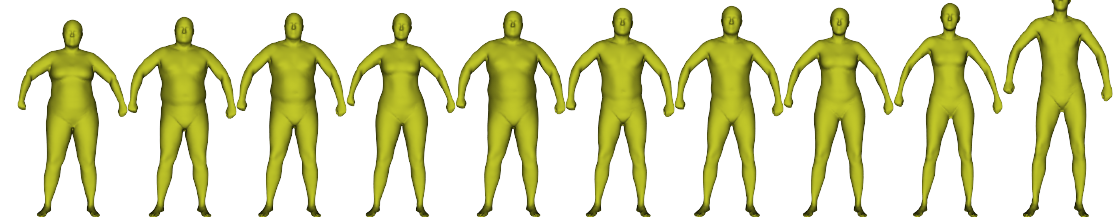
Figure 7. Ten representative human subjects of the same pose in the SHREC-RE dataset [1].